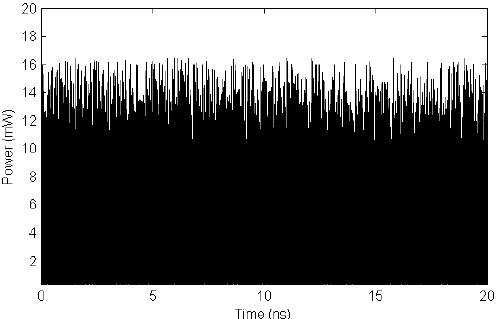
Figure 6. Temporal evolution of the power of the Stokes signal generated in the HNF.